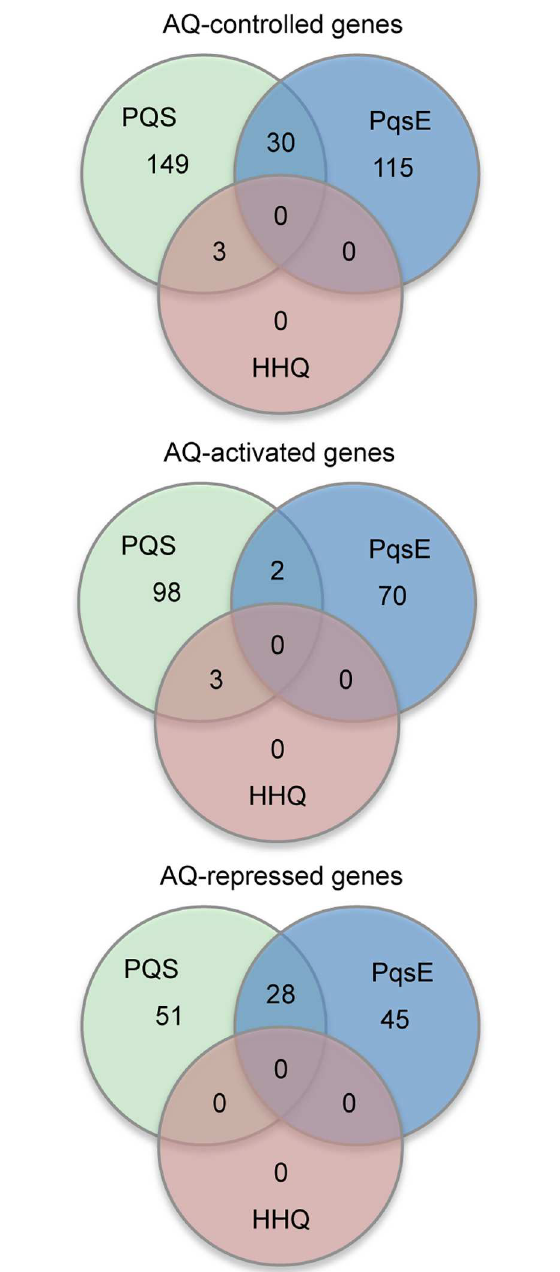
Fig 2. The AQ and PqsE regulons. Venn diagrams showingthe number of genes controlledby HHQ, PQS, and PqsE in P . aeruginosa Δ 4AQ, and the overlapbetween the